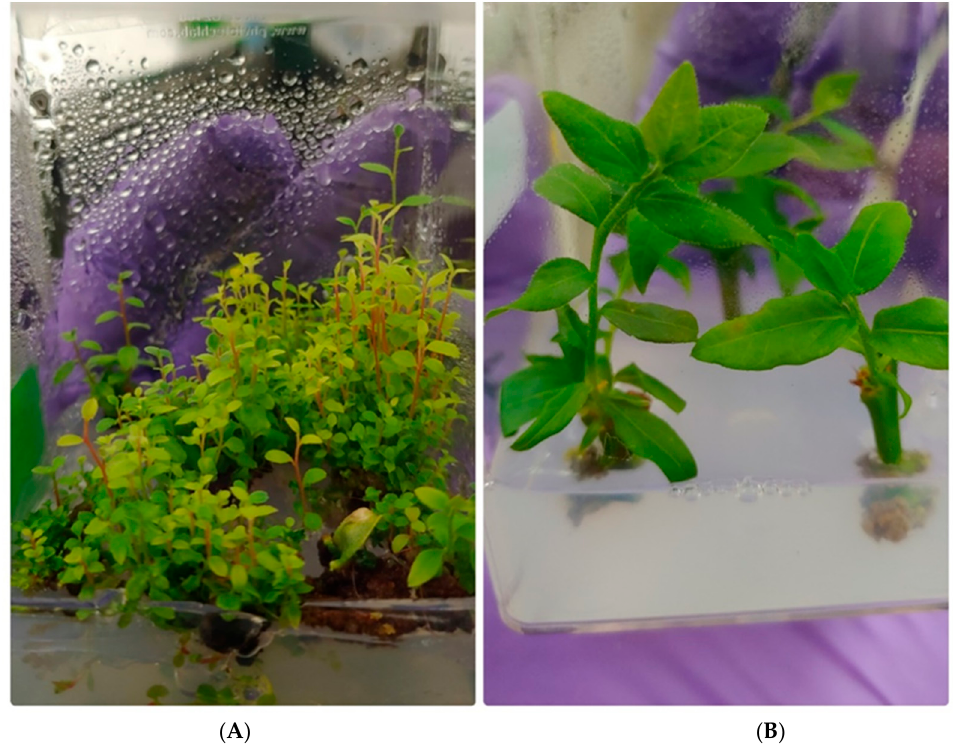
Figure 1. Example of different low chill highbush blueberry plant architectures after 8 weeks in tissue culture. ( A ) an architecture characterized by numerous meristems and small leaves from the cultivar “Legacy” grown on stock culture media containing 4 mg of zeatin and under RB LED lights. ( B ) an architecture characterized by a single shoot and large leaves from the cultivar “FL11-35” grown on stock culture media containing 1 mg of zeatin and under fluorescent white lights.